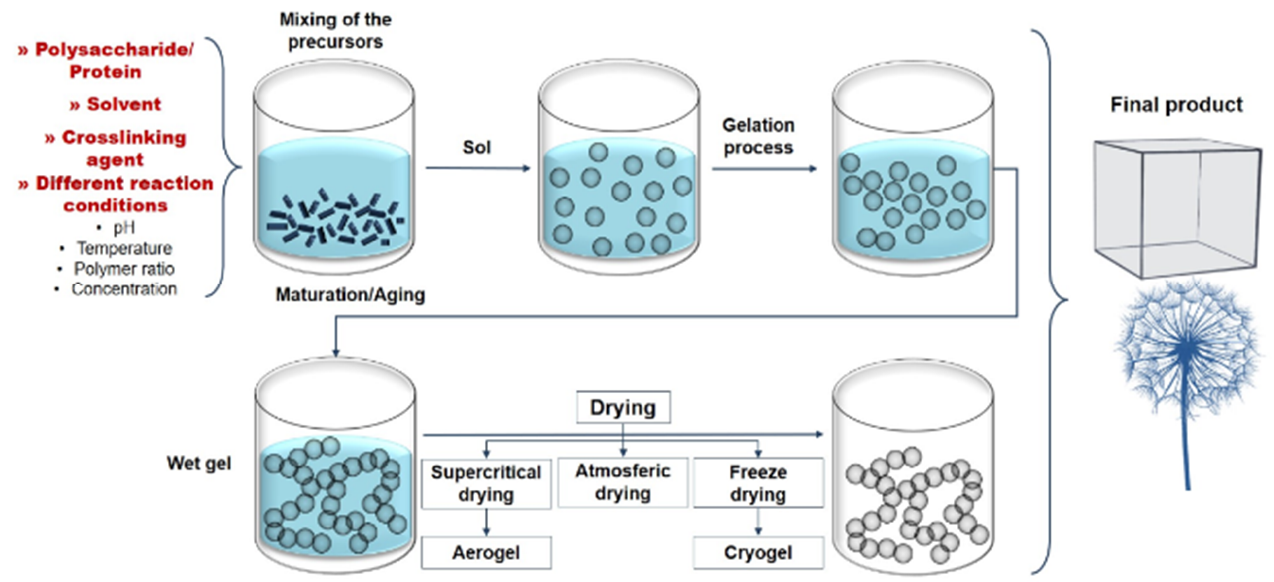
Figure 4. A general method for the preparation of aerogels. Adapted from Nita et al. [71].